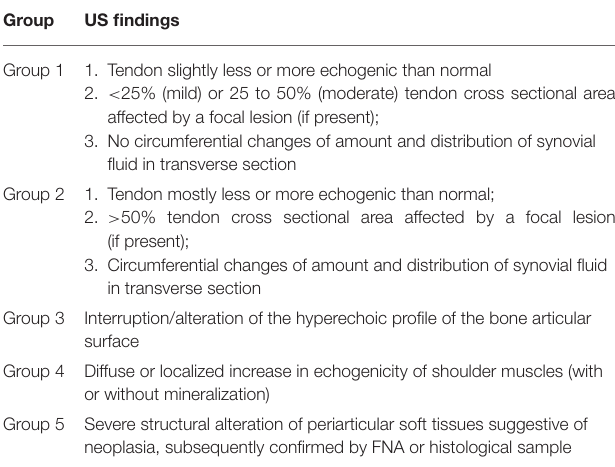
TABLE 1 | Specific US findings for the classification of dogs in different groups.